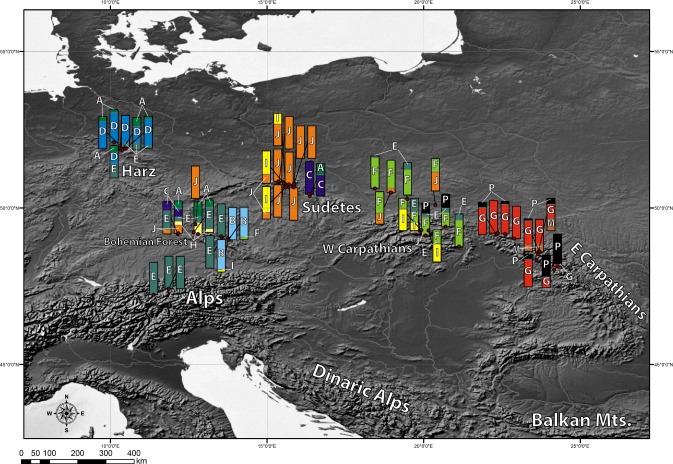
Geographic distribution of cpDNA haplotypes present in the investigated populations of A. halleri.Bar charts represent the frequency of each haplotype in each investigated population.